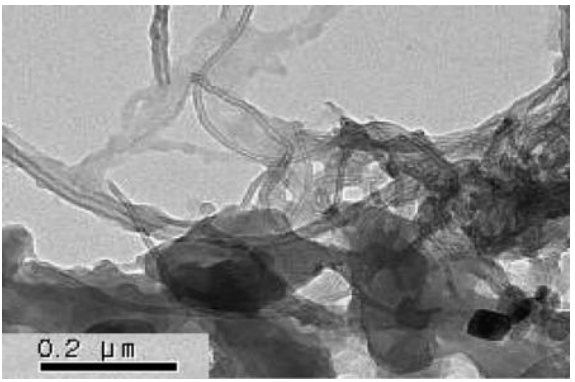
Figure 6. TEM image of the MWNT/PANI nanocomposite (reprinted with permission from [31], Copyright 2007